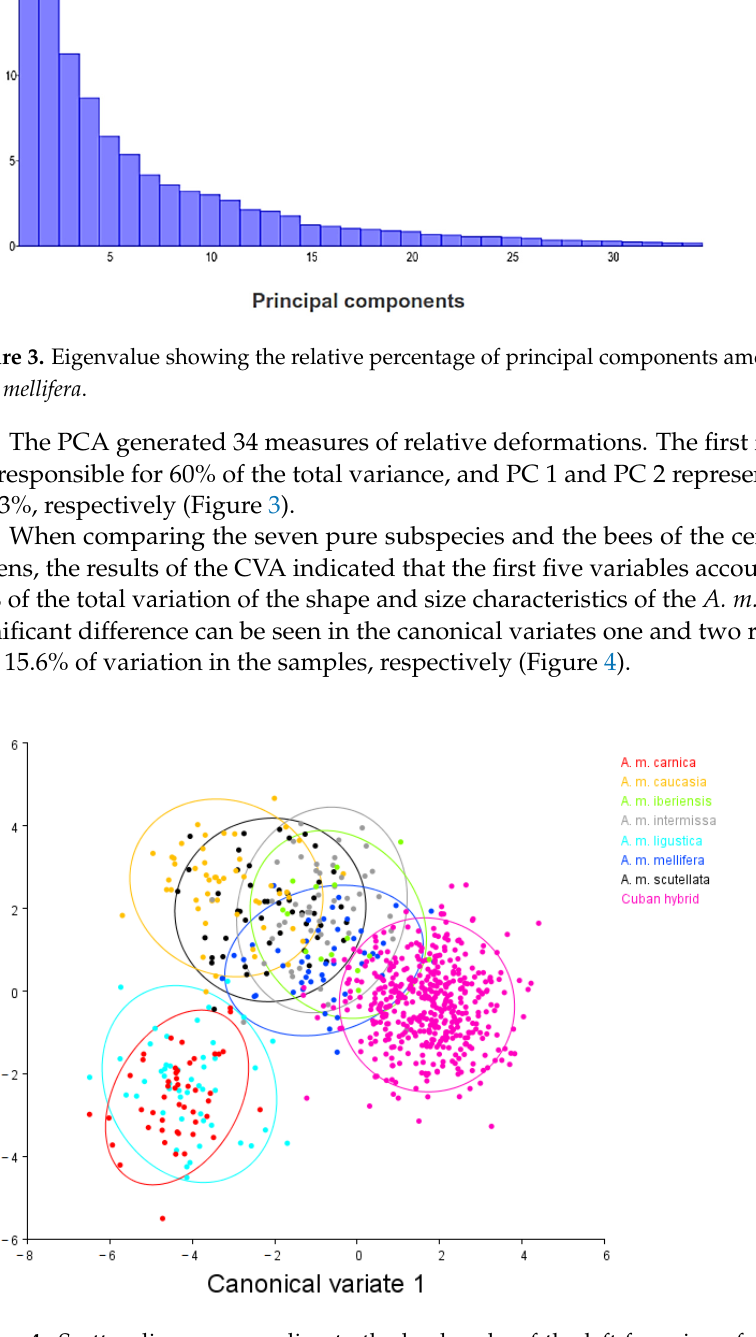
Figure 4. Scatter diagram according to the landmarks of the left forewing of Apis mellifera from the centers for rearing queens. CVA: considering pure subspecies, Red: A. m. carnica , Orange: A. m. caucasia , light green: A. m. iberiensis , gray: A. m. intermissa , light blue: A. m. ligustica , blue: A. m. mellifera , Black: A. m. scutellate , and centers for rearing queens under study. Ellipses are drawn with 90%